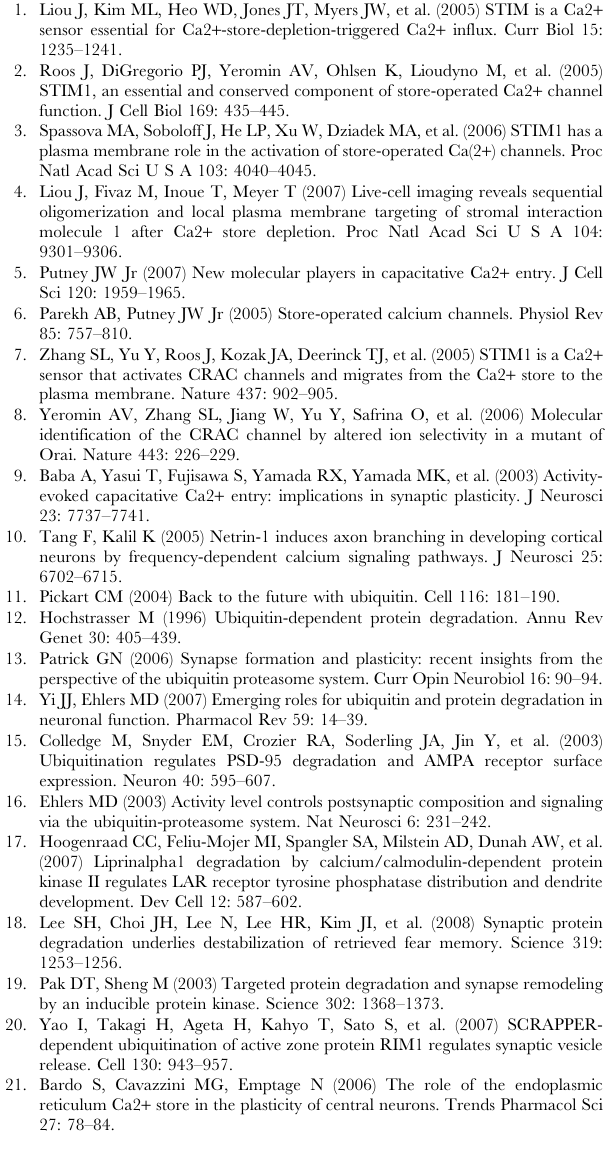
Figure 3. Rat hippocampal neurons (DIV 18) were infected with Sindbis STIM1-GFP virion. Expression was allowed to continue for 12 hours prior to live-imaging of STIM1-GFP expressing neurons in vehicle and thapsigargin (TG; 2 m M final) containing imaging bath solutions to deplete ER calcium stores. Confocal images were taken at 2 min. intervals before and after the addition of 2 m M TG (TG added at T = 0). Scale bar = 10 m m. Found at: doi:10.1371/journal.pone.0013465.s009 (4.15 MB